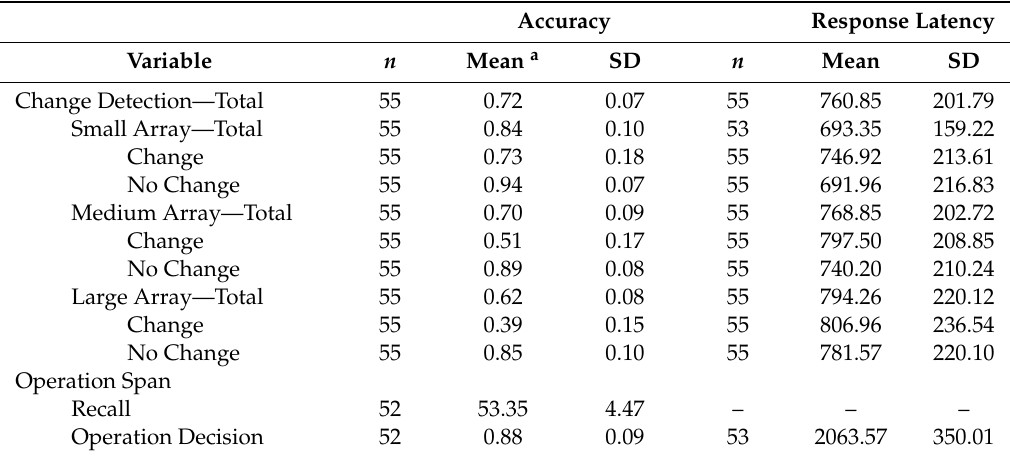
Table 1. Descriptive Statistics for Change Detection and O-Span